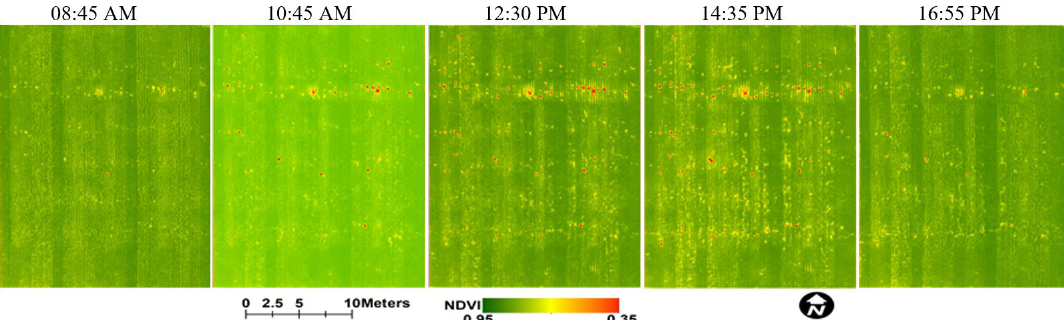
Figure 9. Visualization of spatial and diurnal change of canopy temperature, which indicates stress development and recovery from north to south of the field corresponding to from 0.3 m rooting depth to 0.45 m, 0.6 m, and 0.75 m rooting depths divergence